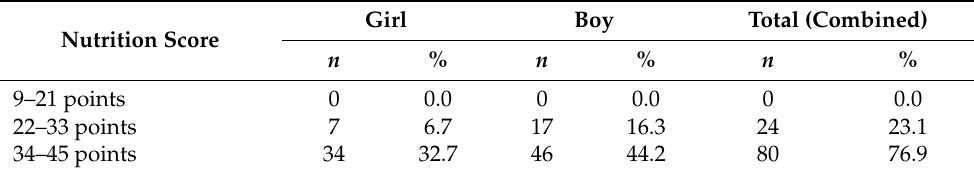
Table 3. Children’s Nutrition